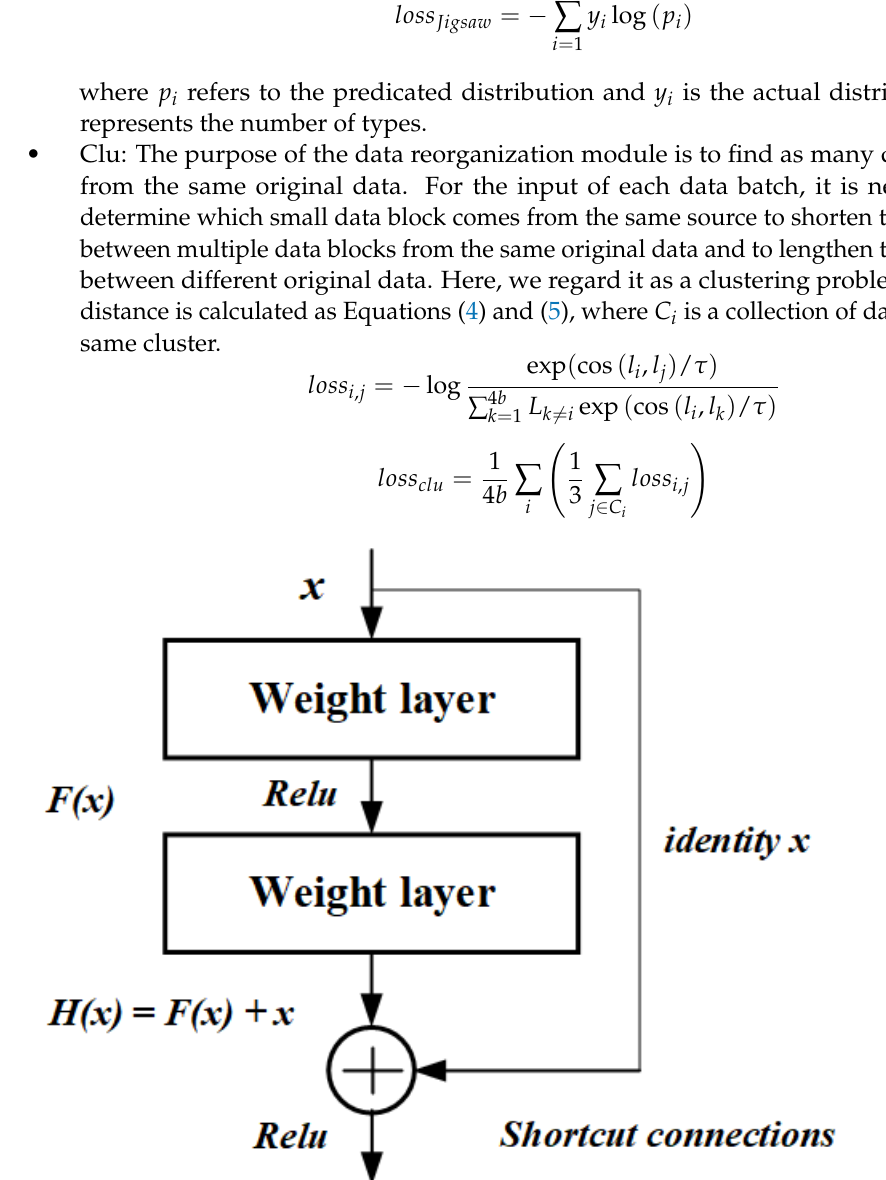
Figure 4. The pre-training model in the algorithm of